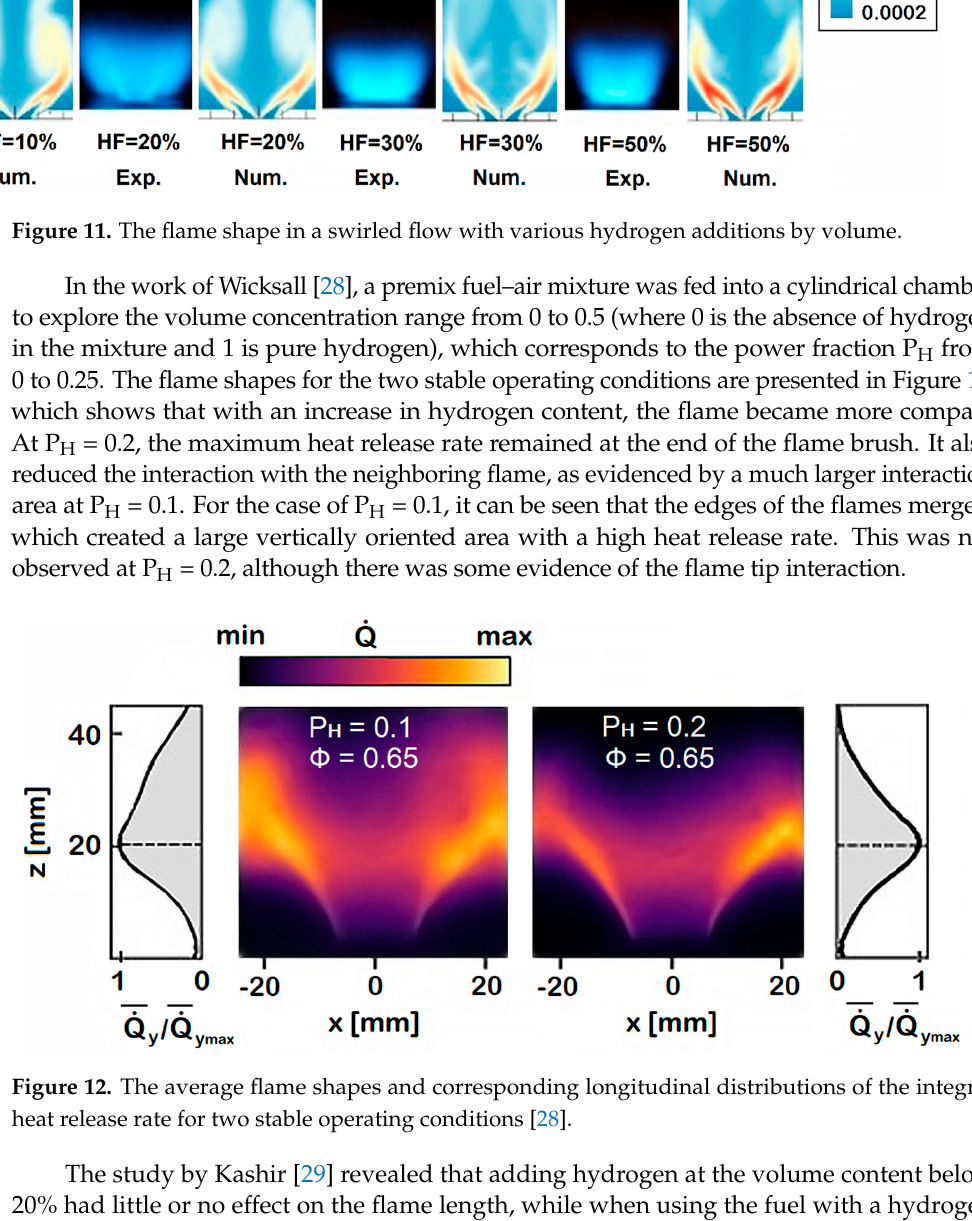
Figure 11. The flame shape in a swirled flow with various hydrogen additions by volume.